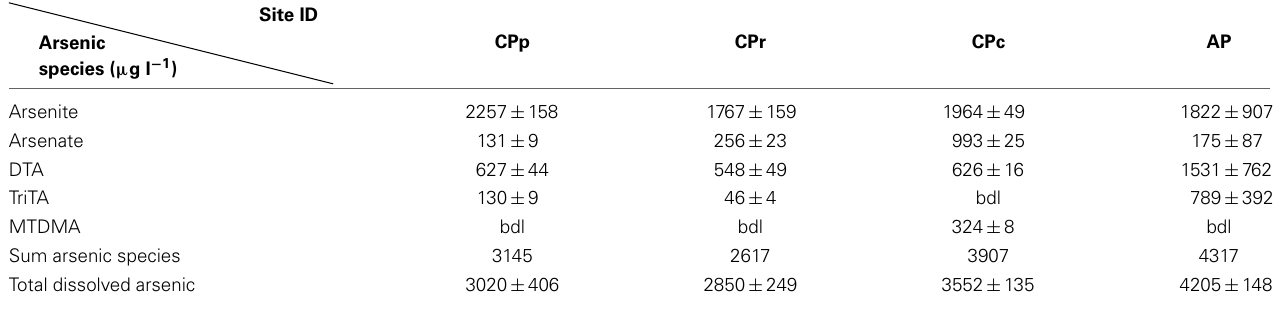
Table 2 | Arsenic speciation and total dissolved arsenic concentrations in Champagne